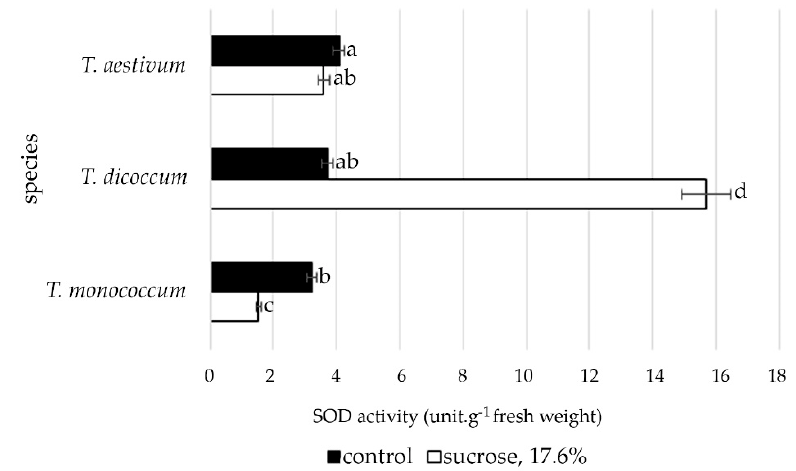
bar = 10 µm. scale bar = 10 µ m.